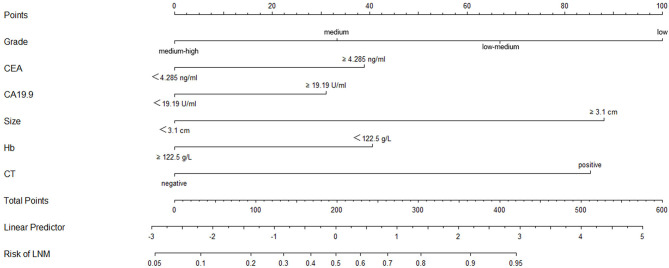
Nomogram of the logistic regression model constructed by grade, CEA CA19-9, tumor size, Hb, and CT findings. The points corresponding to the indicators were added to obtain the total points; the higher the total points, the higher the risk of LNM in GC.